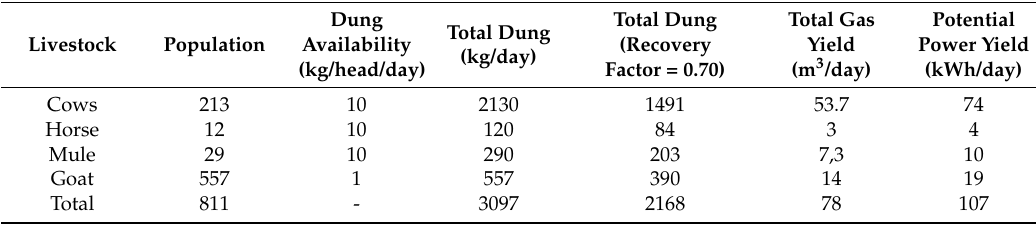
Table 5. Electricity potential from biomass of the study area.